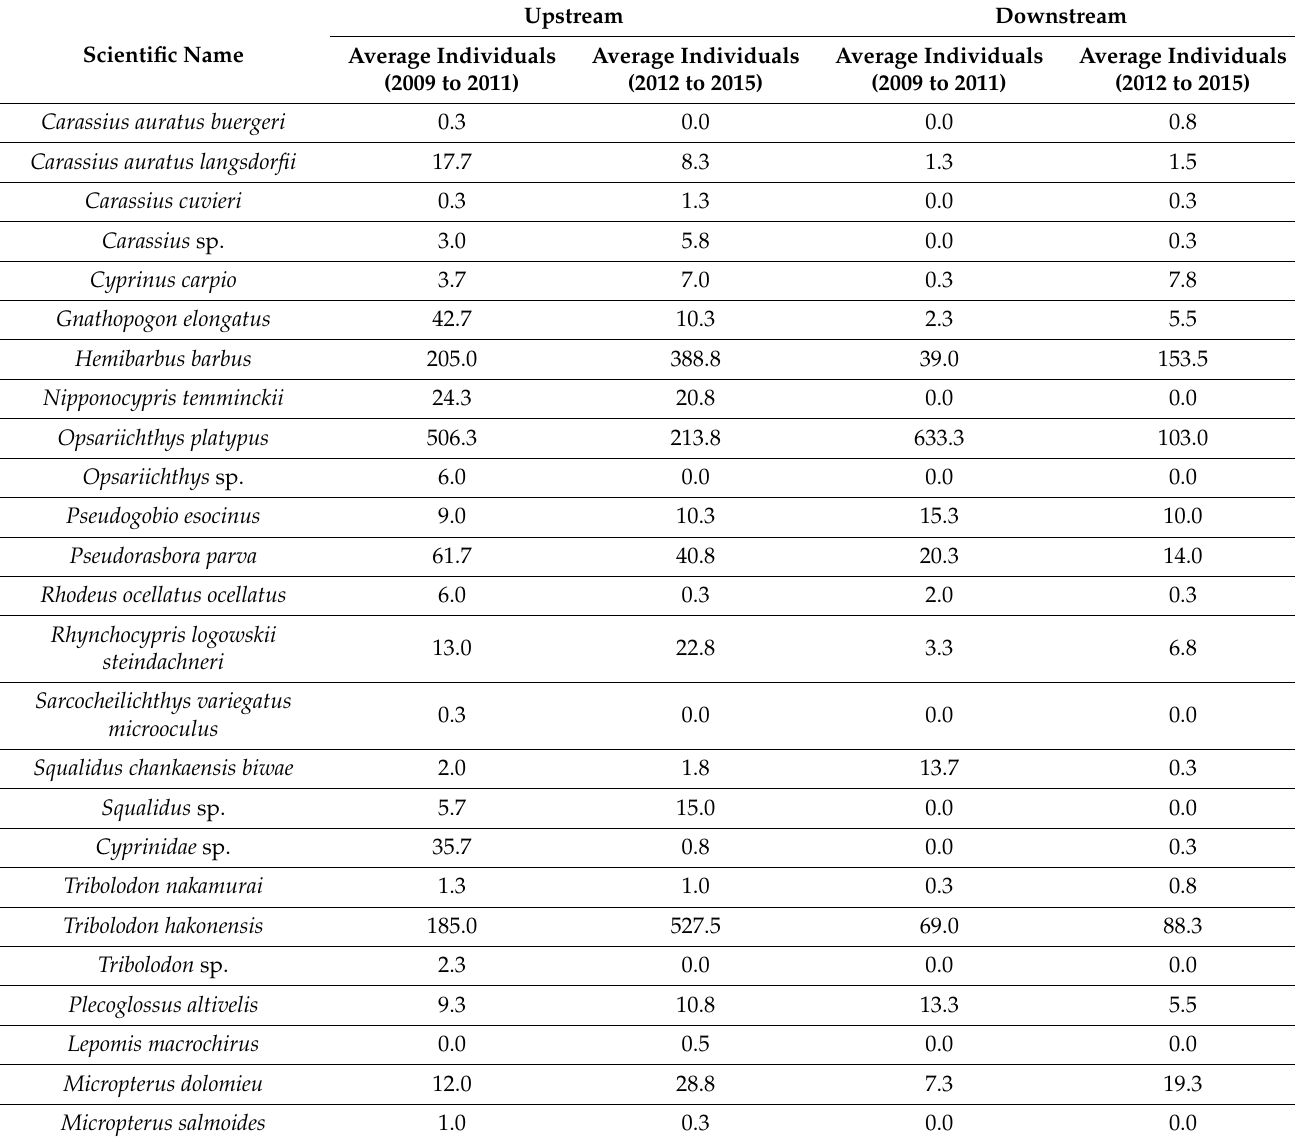
Table 7. Survey results from 2009 to 2015 at the upstream and downstream points of Miyanaka Intake Dam. The numbers of captured individuals show the average values for each period. These results were obtained by conducting two-day surveys in June, August, and October of each